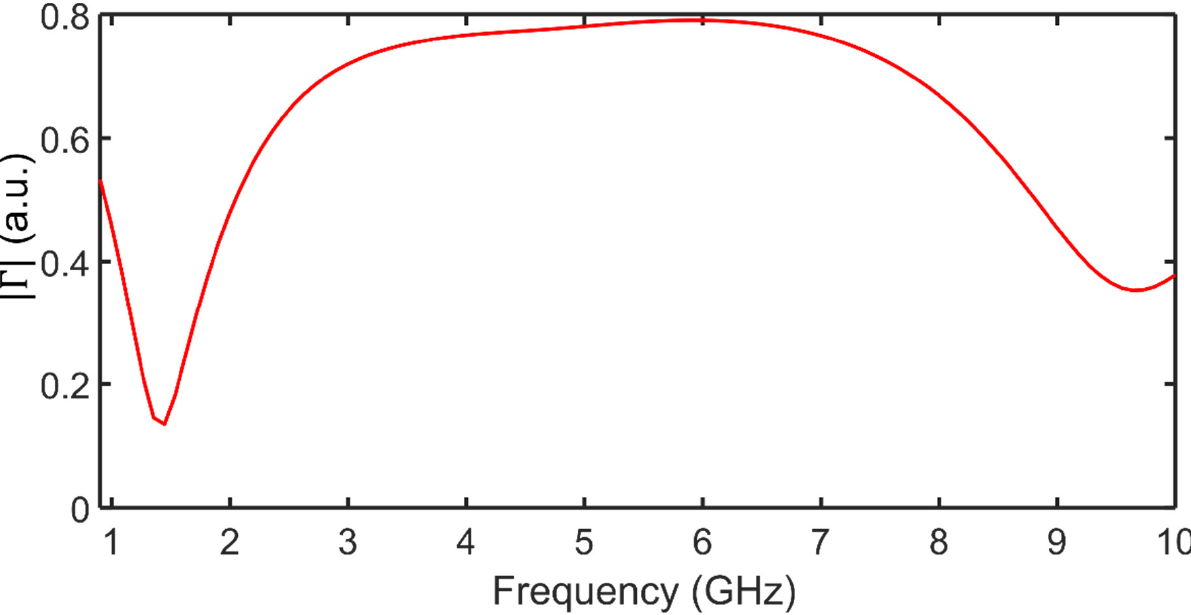
Figure 4. Magnitude of the reflection coefficient ( Γ ) vs. frequency, for the case of a microadenoma.